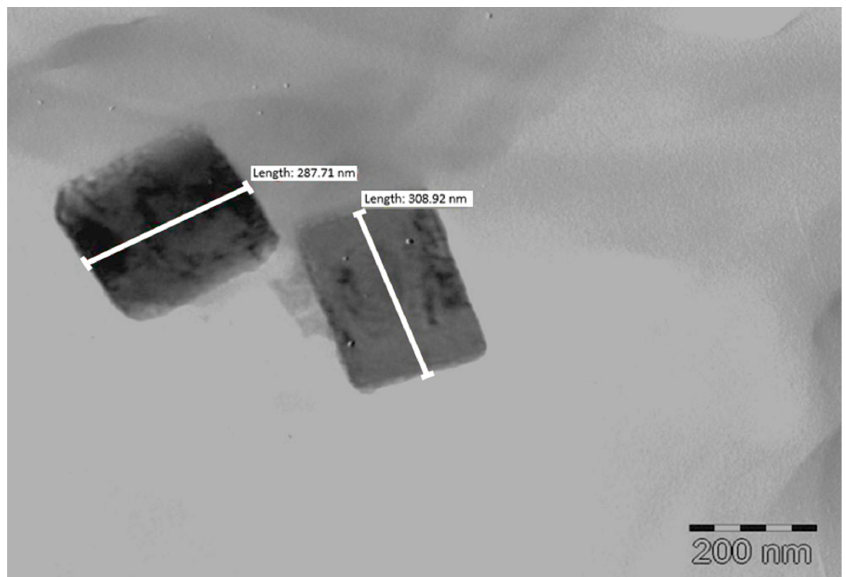
Figure 8. TEM micrograph of prismatic OPT-NCC.